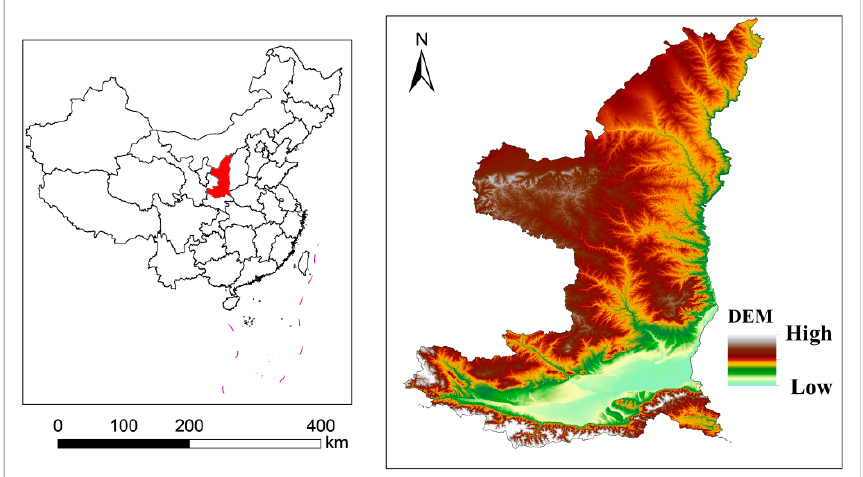
Figure 1. The location of the Yellow River Basin in Shaanxi.